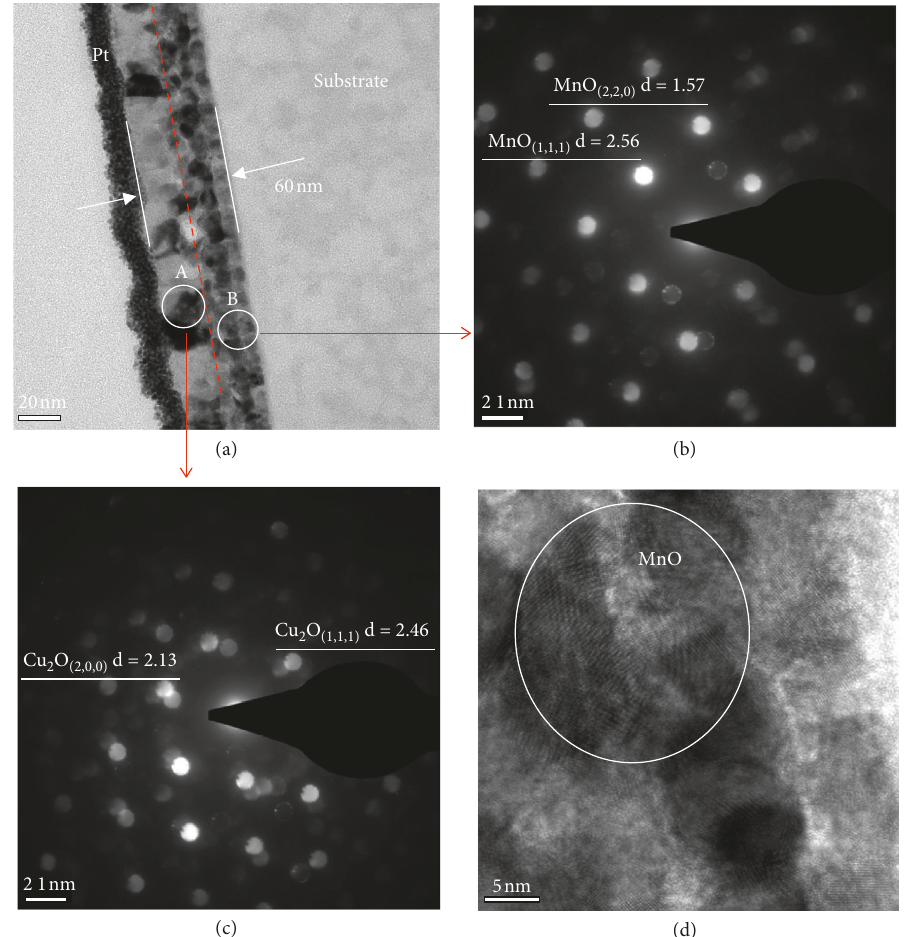
Figure 2: CuMn film TEM micrographs annealed at 350 ° C: (a) cross-section bright field, (b) selected-area electron diffraction at position A, (c) selected-area electron diffraction at position B, and (d) HRTEM micrographs at position B.